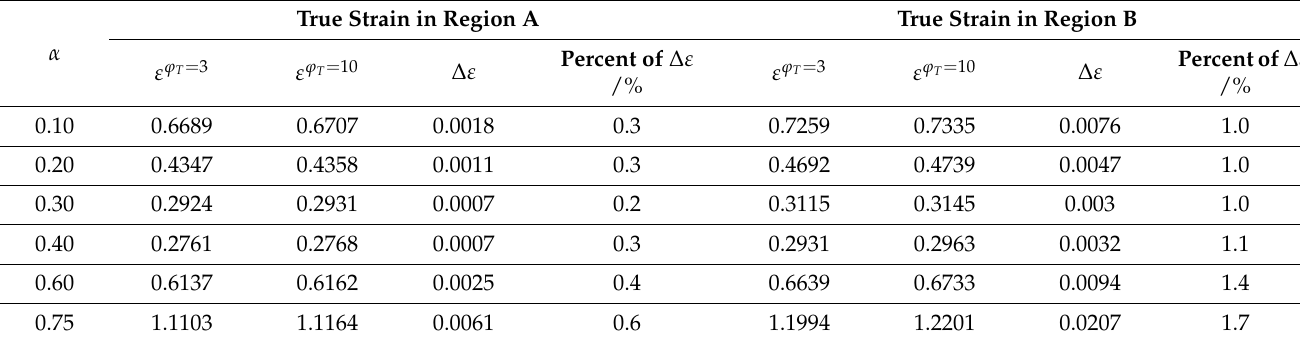
Table 2. The ratio of the strain increment of zone B and A.